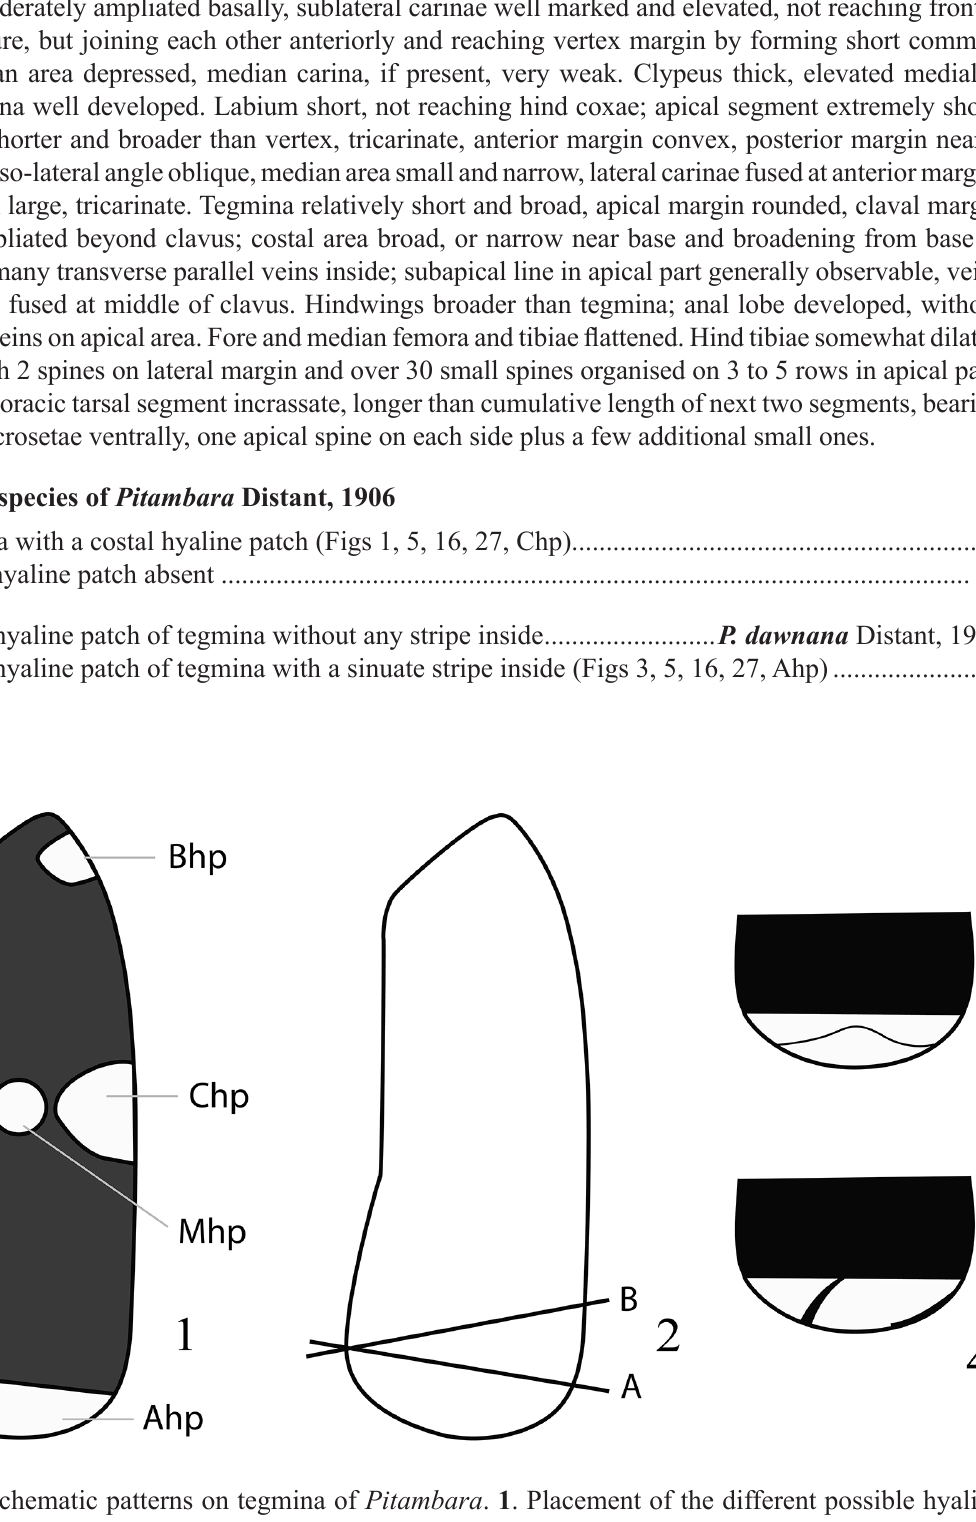
Figs 1–4. Schematic patterns on tegmina of Pitambara . 1 . Placement of the different possible hyaline patches. 2 . Shape of the apical hyaline patch delineated according to the A or B line. 3–4 . Apical hyaline patch with sinuate ornamentation (3) or a thick stripe reaching the apical margin of tegmina